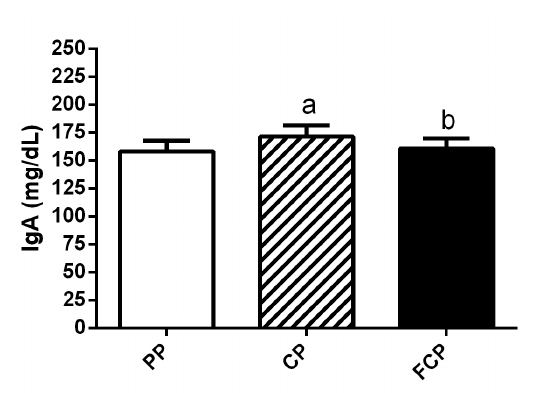
Figure 2. Effect of selective loads periodization on plasma Immu- noglobulin A (IgA) of female futsal players in the beginning of the preparatory (PP), competitive (CP) and final competitive period (FCP). Values are expressed as mean ± SD. a p < .01 compared with the PP; b p < .05 compared with the